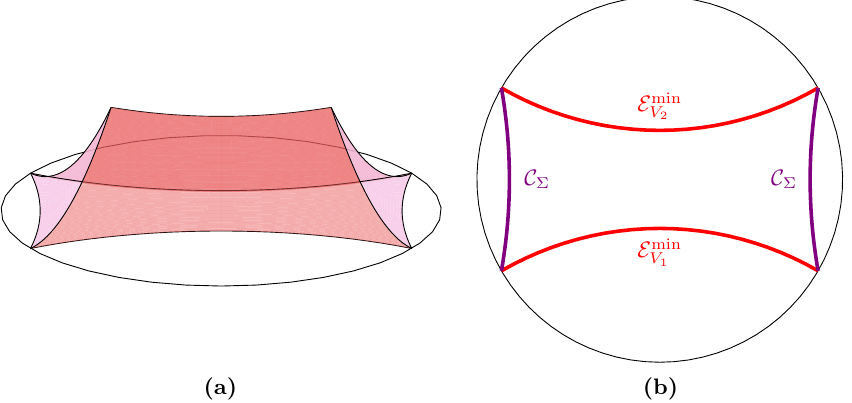
Figure 6. (a) The lift L generated by two HRRT surfaces E min HRRT surfaces and the ridge R are marked with heavy curves. The boundary circle represents a complete achronal slice (cid:6) containing the HRRT surfaces, though the de(cid:12)nition of the lift is (cid:6)- independent. (b) The slope S (cid:6) terminating on a complete achronal slice (cid:6) containing the HRRT surfaces. The contradiction surface C (cid:6) is marked with heavy curves. (Cf. eq. (3.17).).